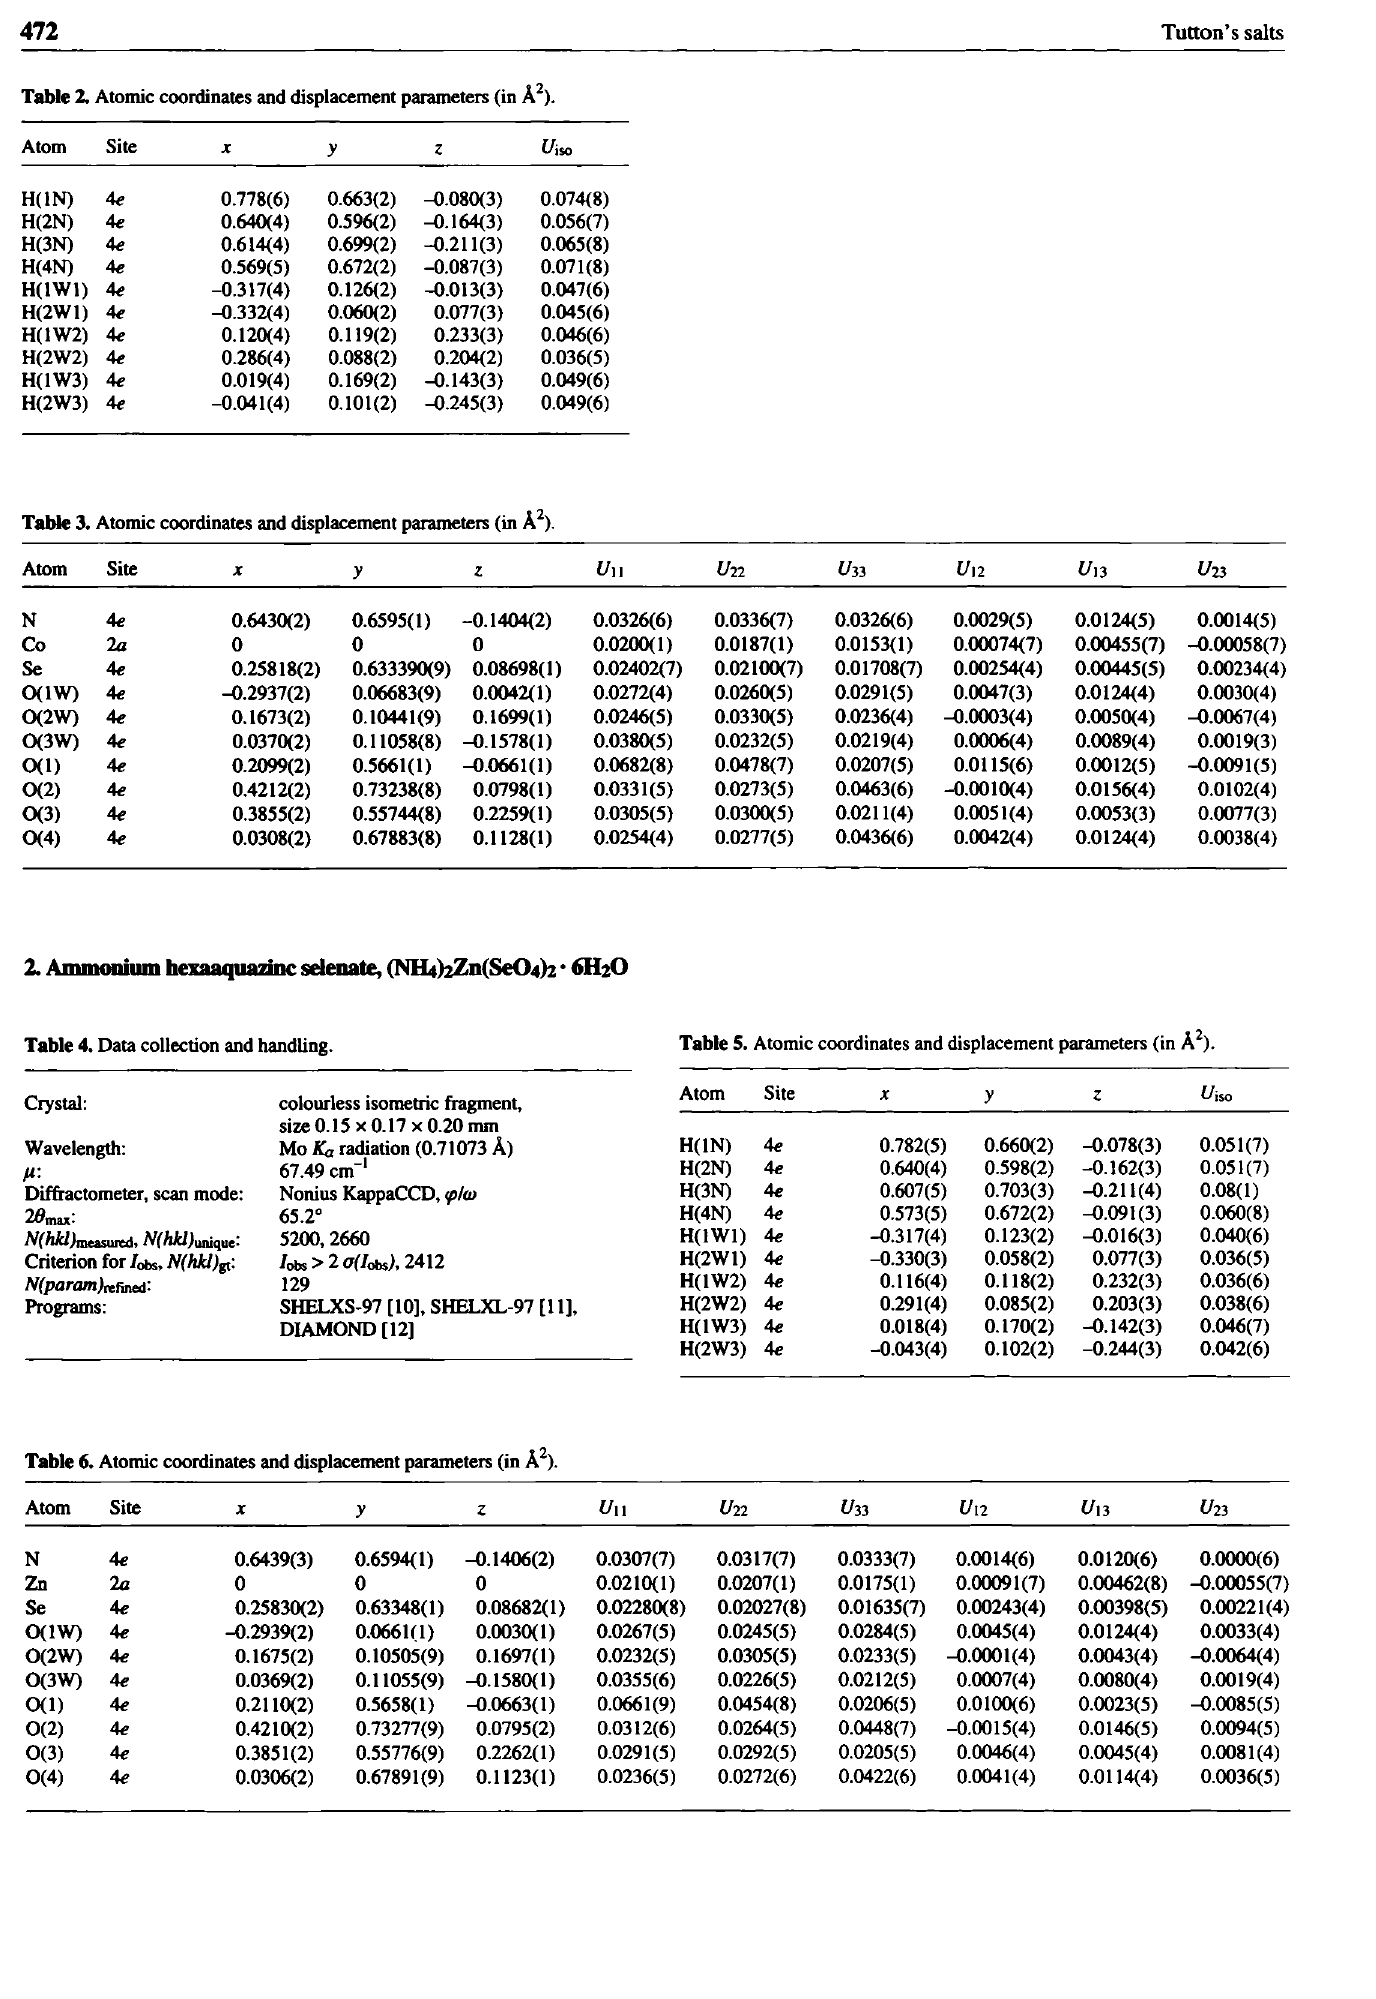
Table 2. Atomic coordinates and displacement parameters (in Â 2 ).